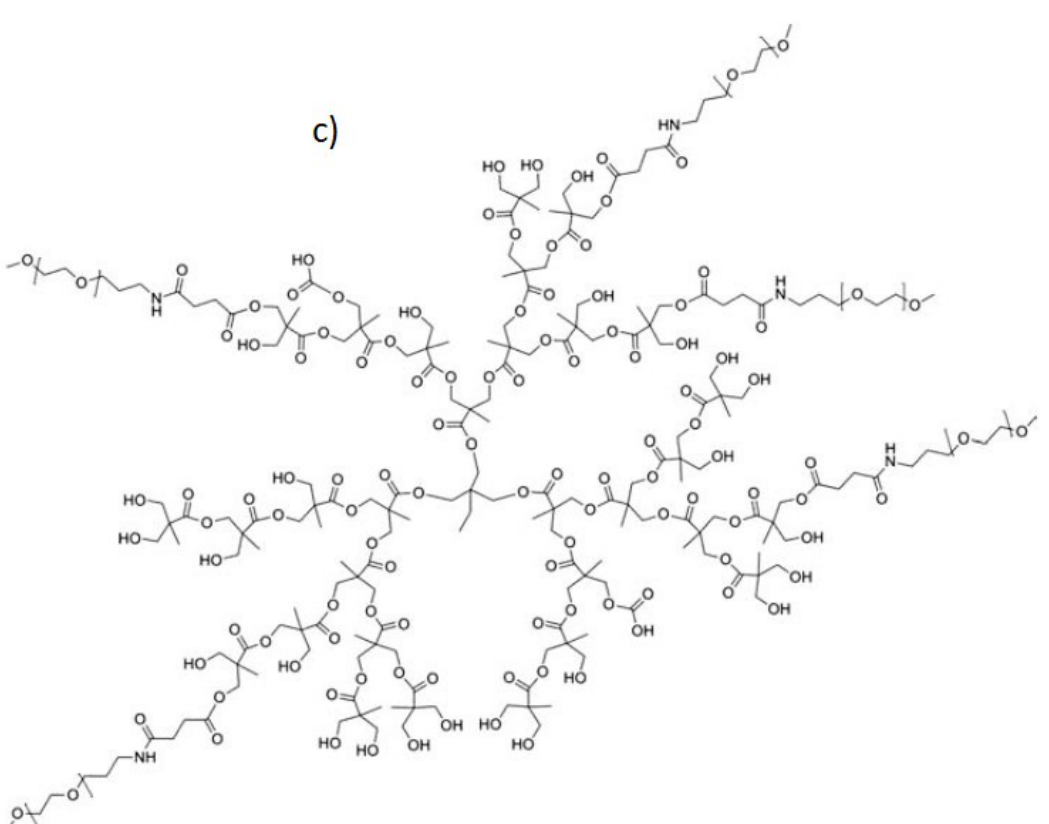
Figure 1. ( a ) A single dipalmitoylphosphatidylglycerol (DPPG) lipid. ( b ) Doxorubicin. ( c ) The structure of the PEGylated hyperbranched polyester. Each PEG arm consisted of 20 monomers.